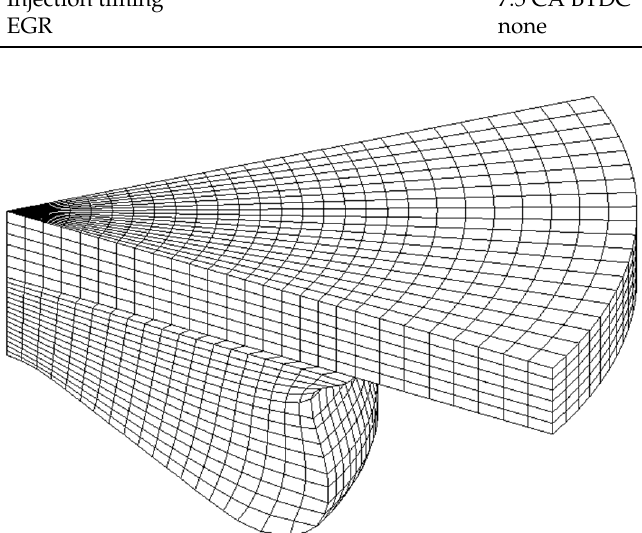
Figure 12. Computational mesh.